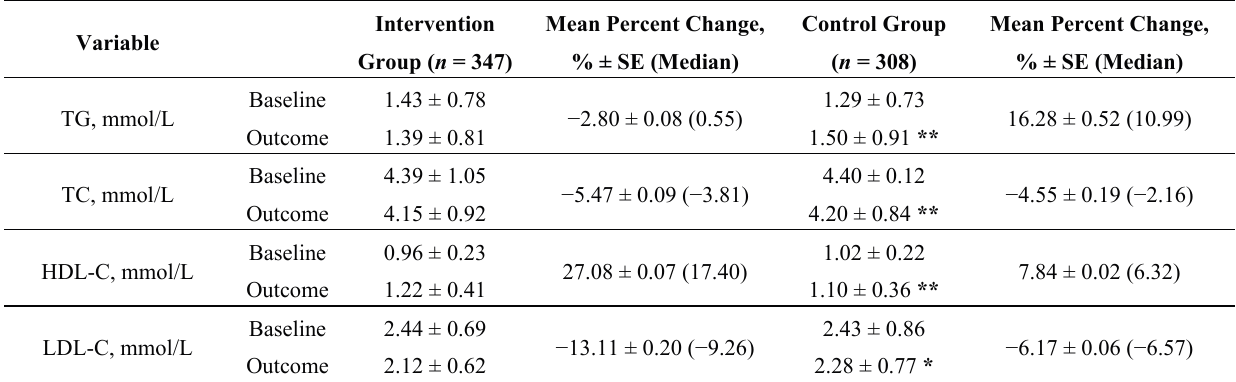
Table 4. Percent change from lipid components between baseline and outcome from intervention and control